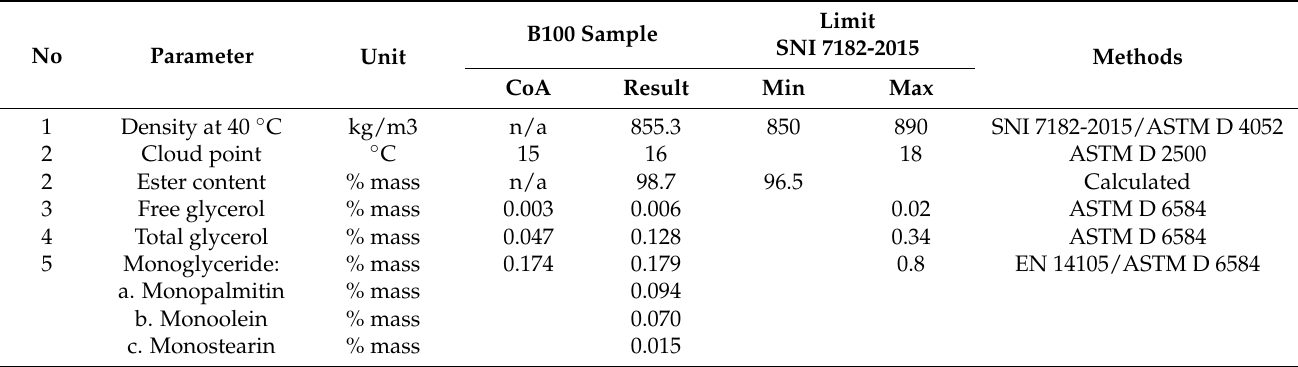
Table 2. Biodiesel fuel (B100) specification and quality.